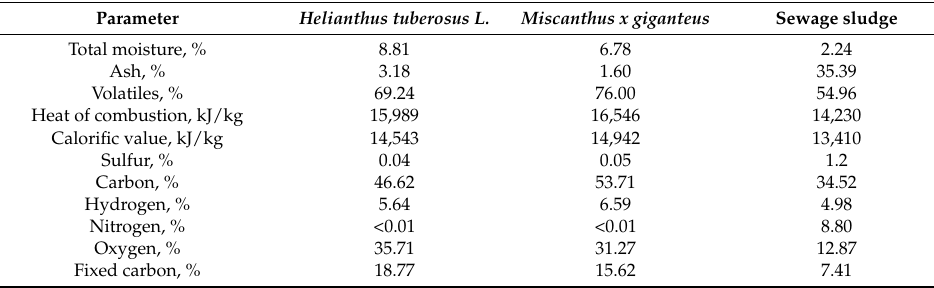
Table 1. Physical and chemical properties of samples